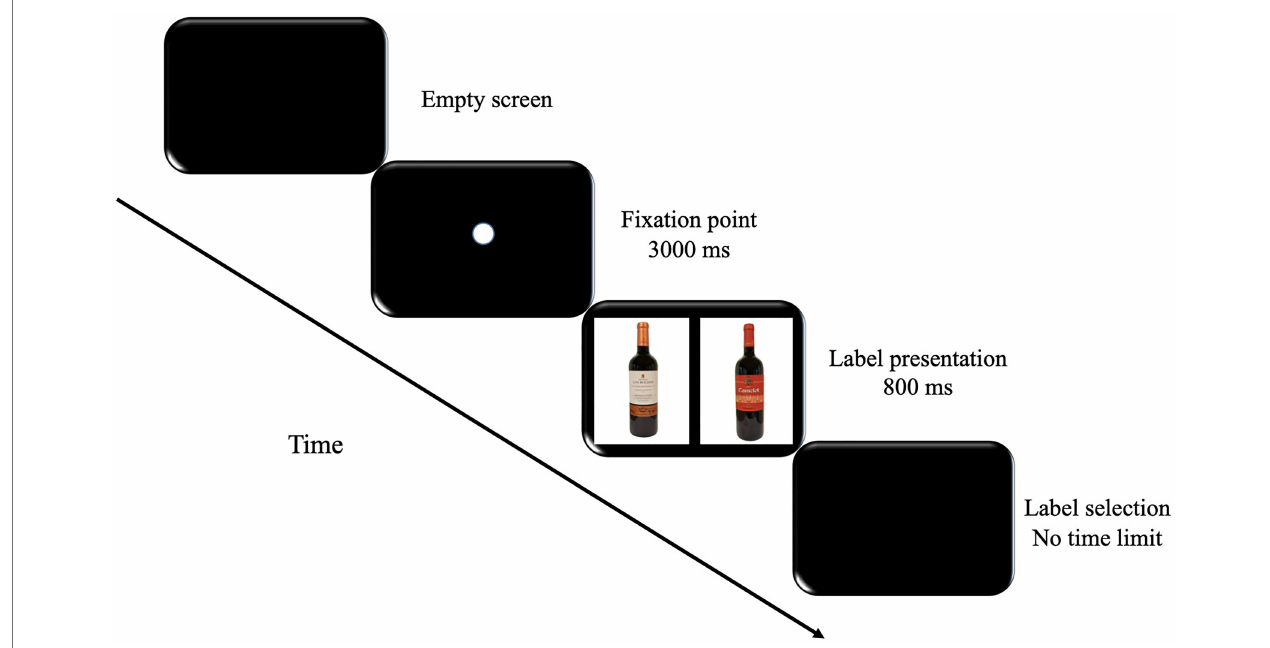
FIGURE 1 | Experimental procedure. Participants were asked to choose the preferred wine after viewing the labeling